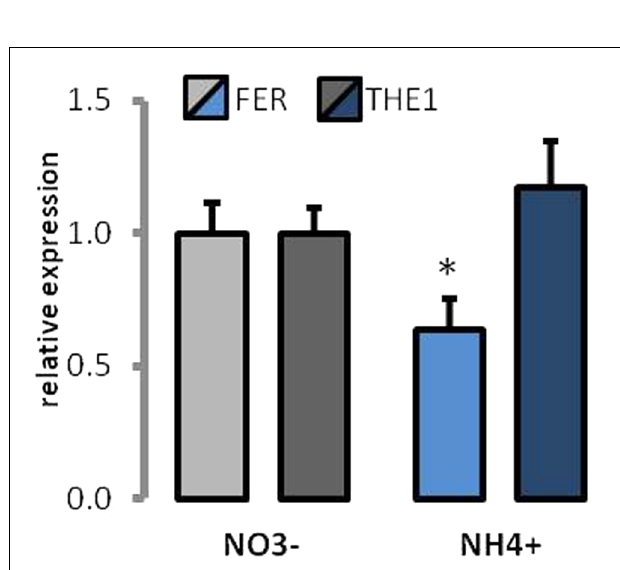
FIGURE 9 | Expression of cell wall receptor-like kinases in plants grown on NH 4 + and NO 3 − (control). Transcript levels for Thesseus1 and Feronia . The value for each gene in control plants was set as